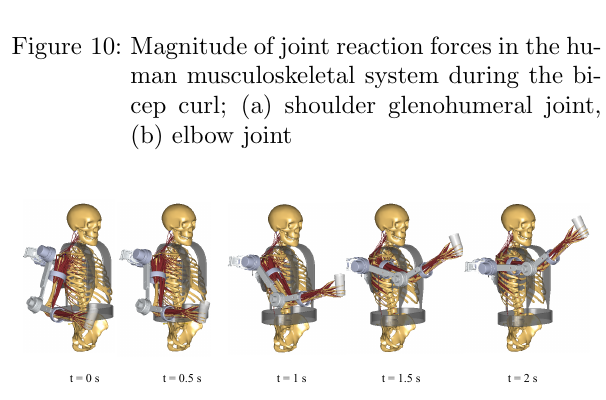
Figure 11: Simulation study of the human-exoskeleton system during the overhead reach